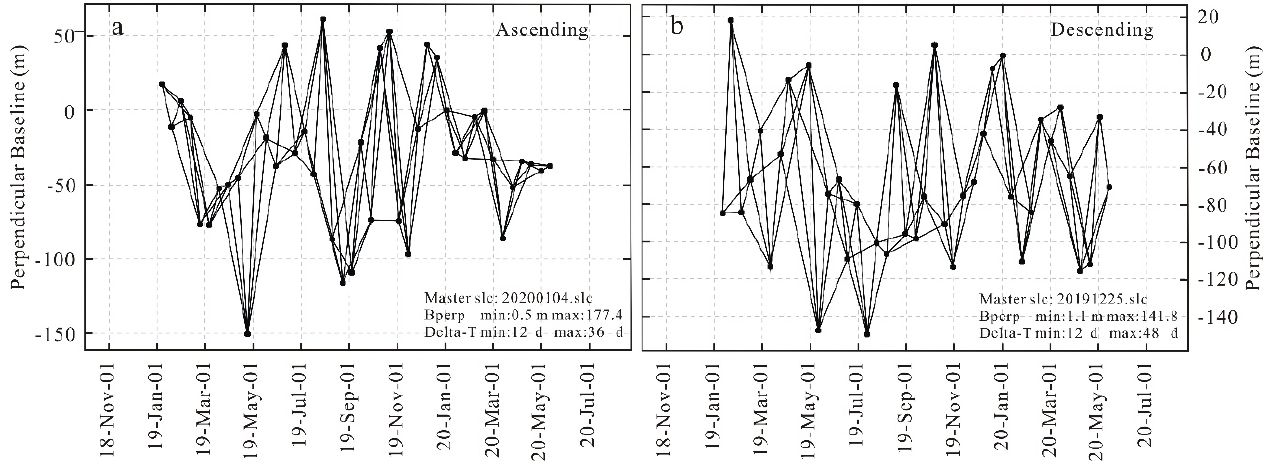
Figure 4. Interference combinations used in SBAS calculations. ( a ) Sentinel − 1 ascending orbit; ( b ) Sentinel − 1 descending orbit (black dots and lines indicate data acquisition dates and interference pairs, respectively).